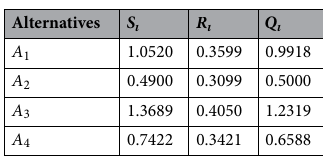
Table 11. S ı , R ı , Q ı for each alternative .